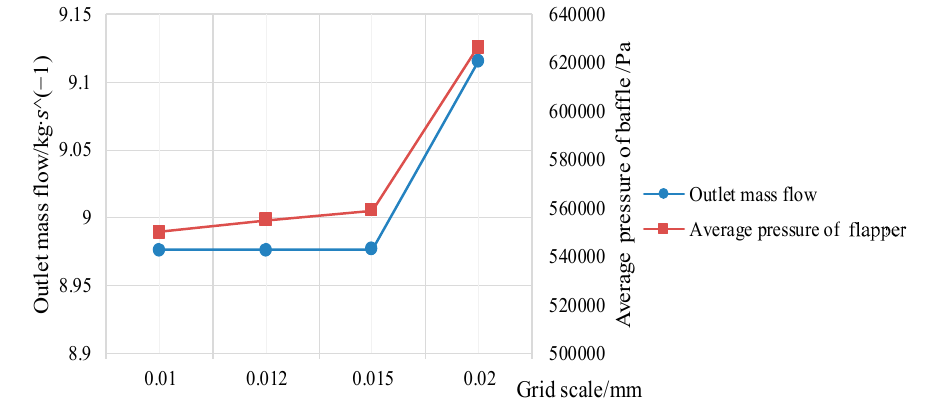
Figure 3. Flow and pressure at different grid sizes.